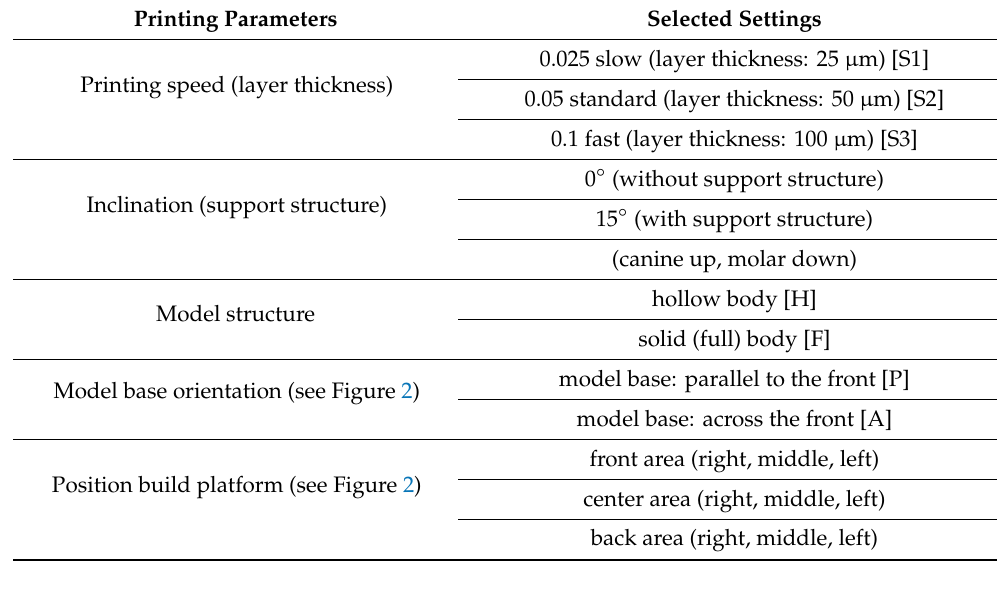
Table 1. Printing parameters and selected (user-defined) settings.